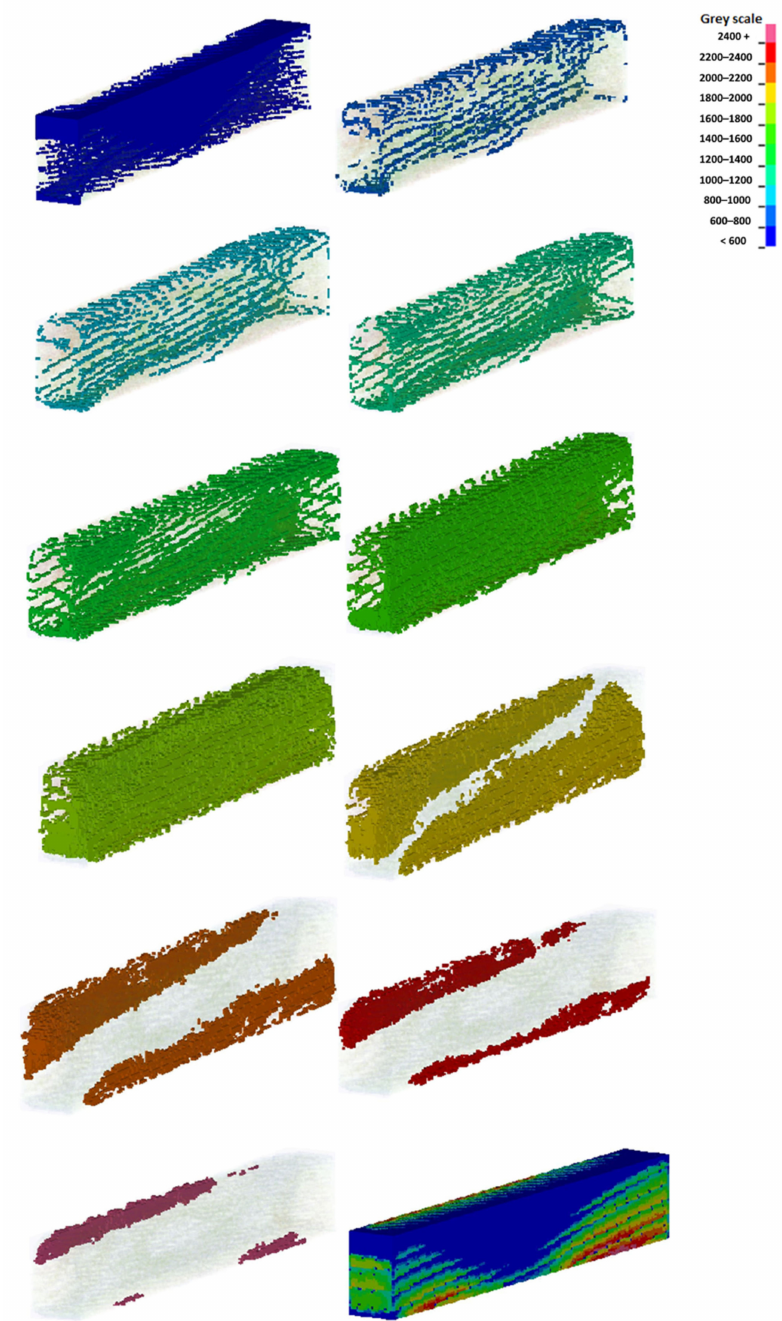
Figure 8. An exemplary division of the voxels sample into groups characterized by a different grayscale range for the K2F3